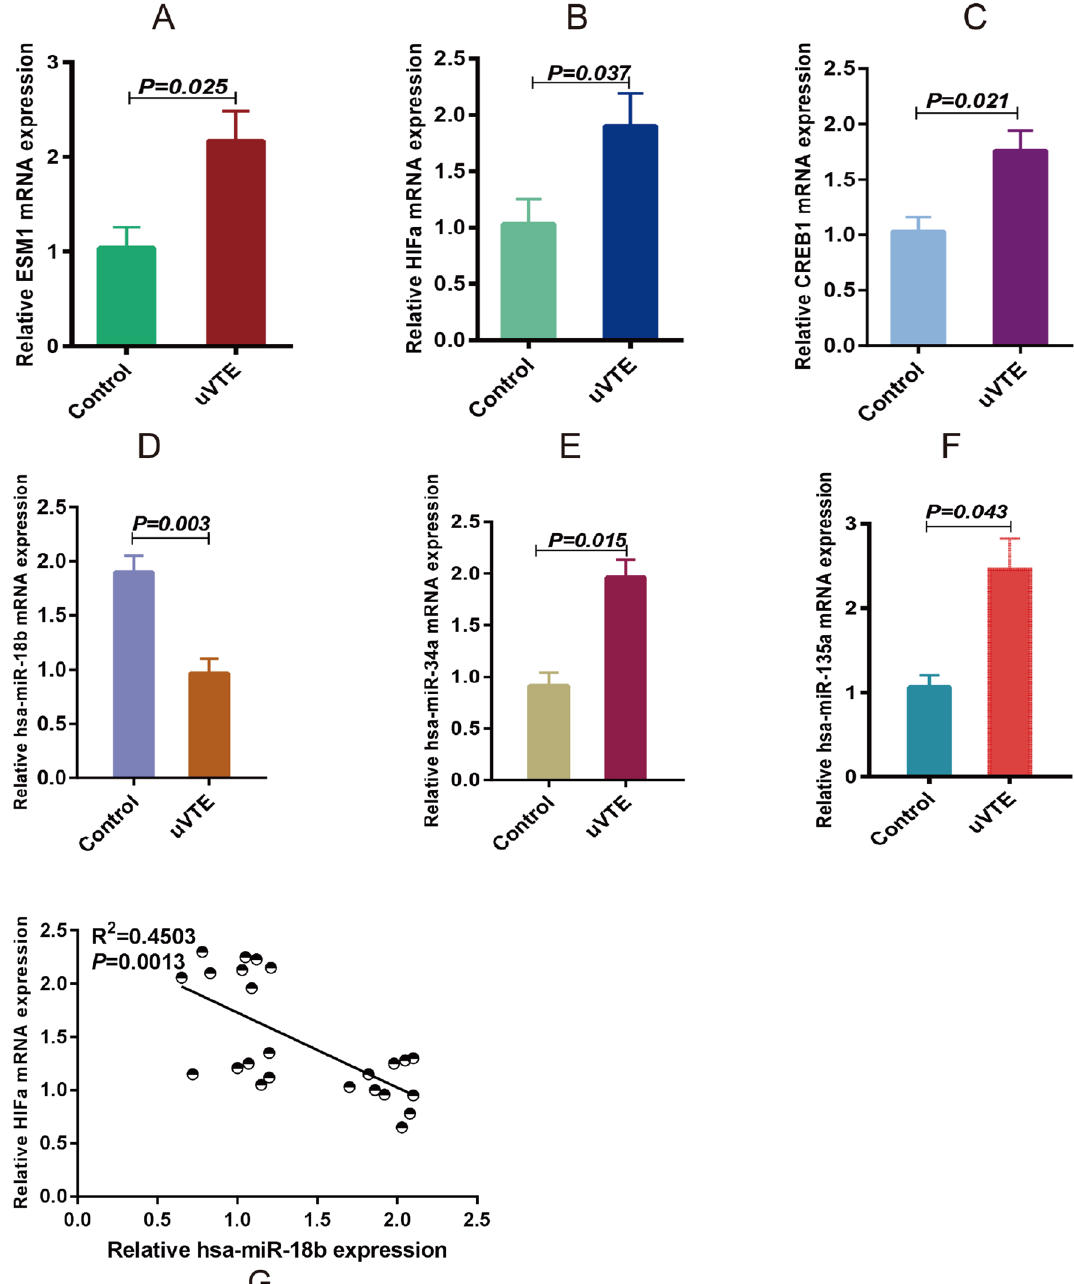
Figure 9. Expression levels of some crucial genes in the plasma of uVTE patients. ( A–E ) ESM1, HIF1α and CREB1 mRNA levels in the plasma of uVTE patients and healthy controls. ( D–F ) hsa-miR-18b, hsa-miR-34a, hsa-miR-135a levels in the plasma of uVTE patients and healthy controls. G, Correlation analysis between HIFa and has-miR-18b. Unprovoked Venous Thromboembolism, uVTE, quantitative Real-time- Polymerase Chain Reaction,